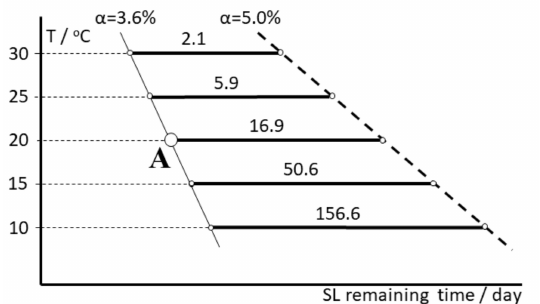
Figure 12. Dependence of the shelf life (SL) remaining time on the isothermal temperature which allows the prediction of the usability of the sample stored at 20 ◦ C with a deterioration progress of 3.6% (point A). The remaining values of the shelf life at temperatures between 10 and 30 ◦ C are displayed in days on the thick horizontal